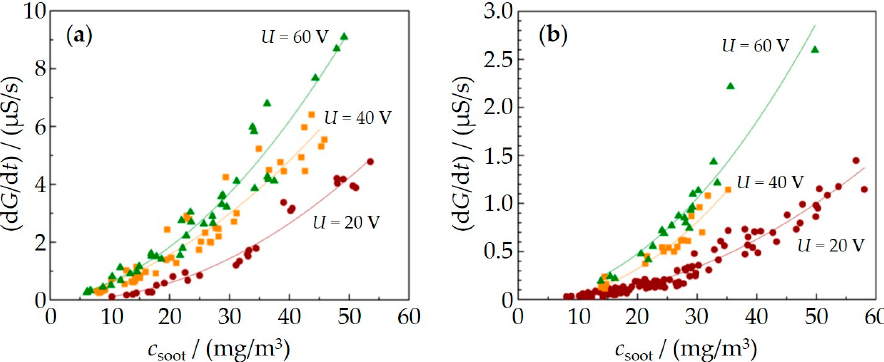
Figure 5. Sensor calibration curves (calculated conductance d G /d t vs. soot concentration) for different types of sensor orientation in the exhaust, either IDE facing the gas flow ( a ) or in the opposite mounting position ( b ).